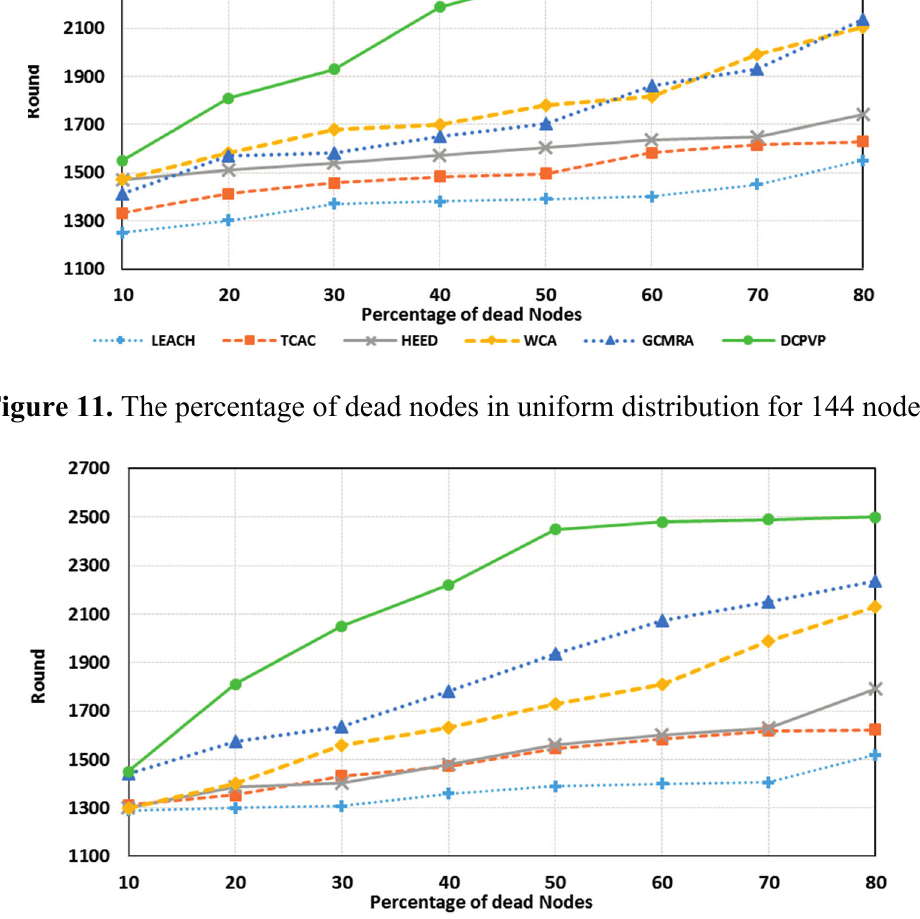
Figure 12. The percentage of dead nodes in uniform distribution for 196